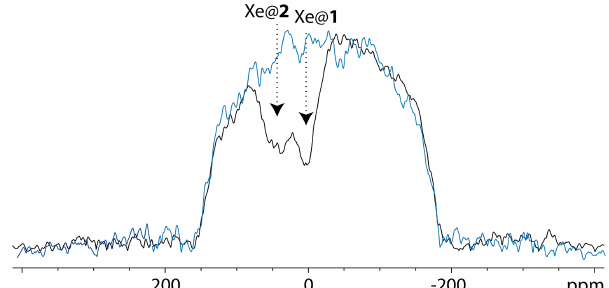
Figure 5. 129 Xe UFZ spectrum of the noble gas into the solu- tion containing the cryptophane mixture at 1T and 295K, using the same pulse sequence as for Fig. 4 (sum of two experiments with sat- urations of 2 and 4s). The saturation offset was placed at the Xe@1 frequency. In black: the profile obtained after saturation at a field strength B 1 = ω 1 /γ = 0.87µT ( on experiment); in blue: same pro- file without saturation ( off experiment); other important parameters: G sat = 21mTm − 1 ; G acq = 84mTm − 1